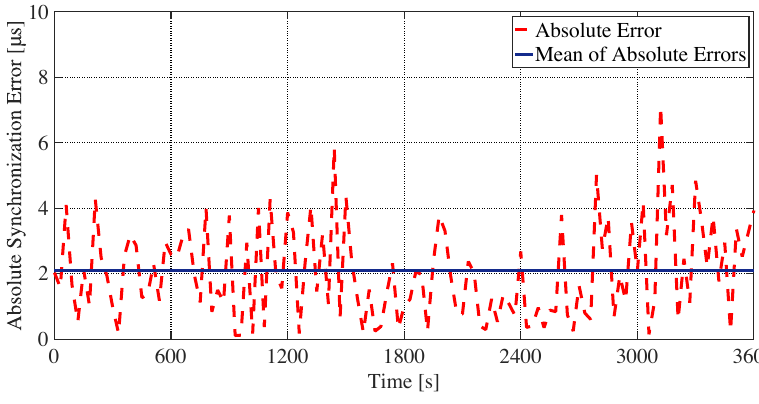
Figure 10. Absolute time synchronization error of node 2 during the experiment of static requirement setting with maximum bundling number of 10 and end-to-end (E2E) delay requirement of 8s illustrated in Figure 8a.